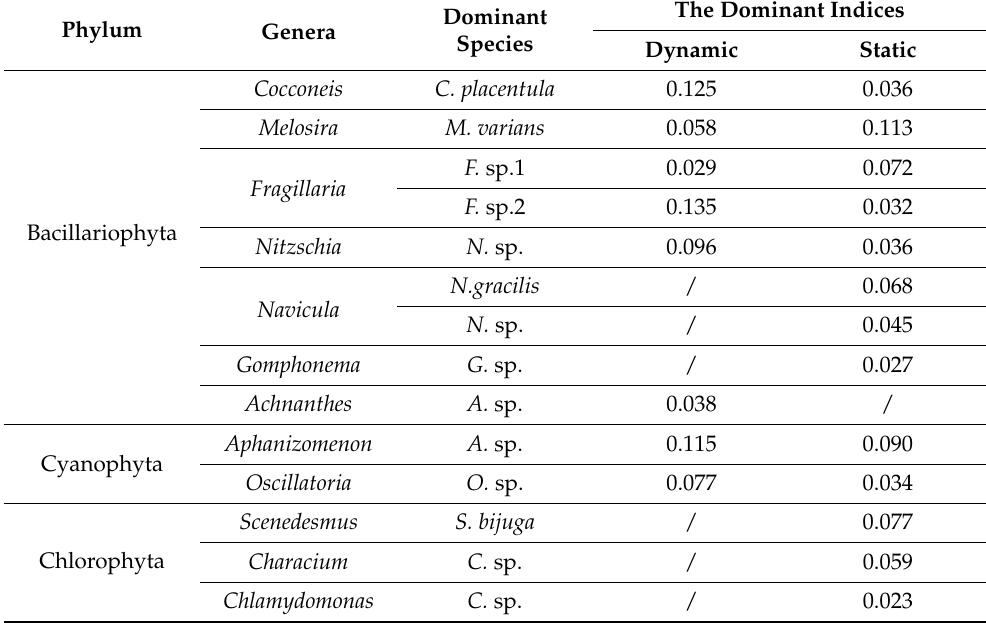
Table 1. Effects of water flow on the dominant genus, species and dominant index on the epiphytic biofilm of V. natans . Phylum Genera